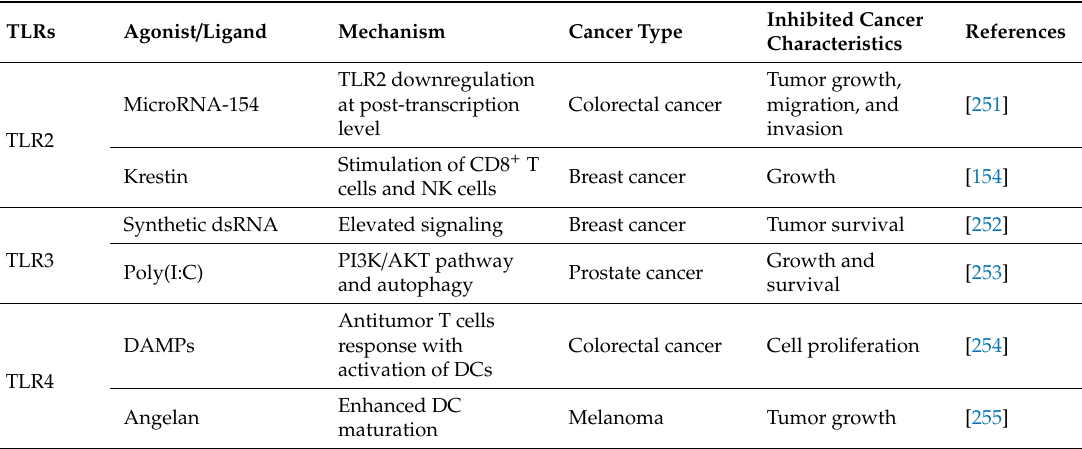
Table 2. TLRs with an antitumor e ff